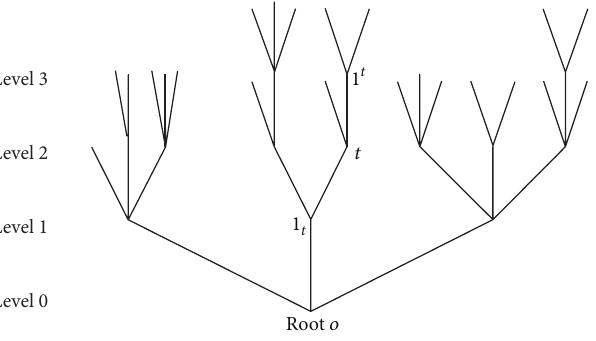
Figure 1: Uniformly bounded tree 𝑇